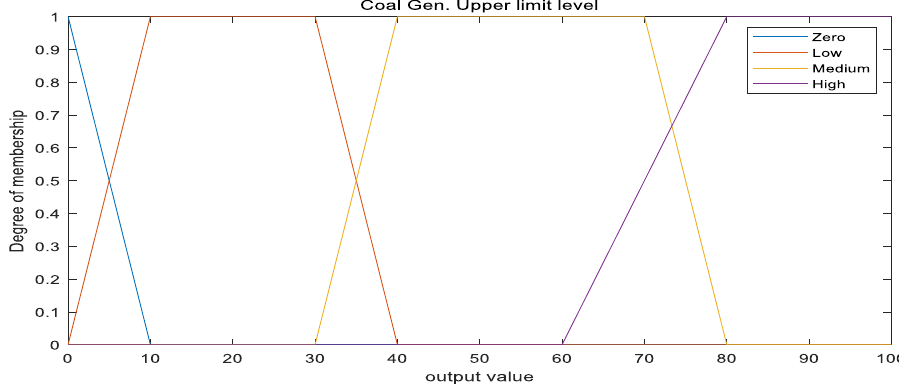
Figure 7. Output membership function.